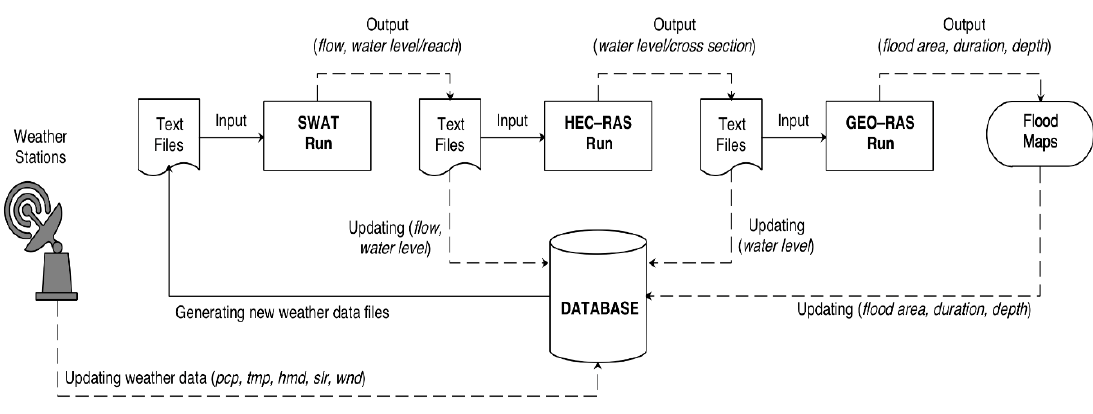
Figure 7. SWAT HEC–RAS module for real-time flood forecasting.